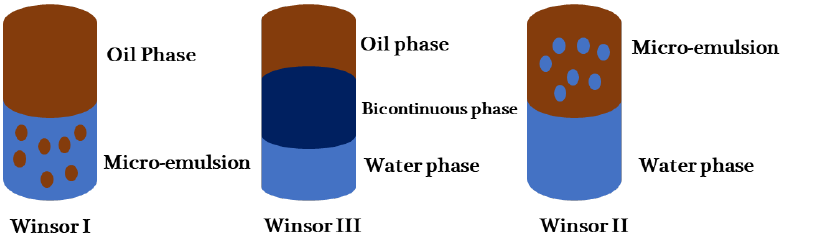
Figure 2. Schematic of Winsor I, II, and III micro-emulsion. Table 4. Winsor I, II and III micro-emulsions.